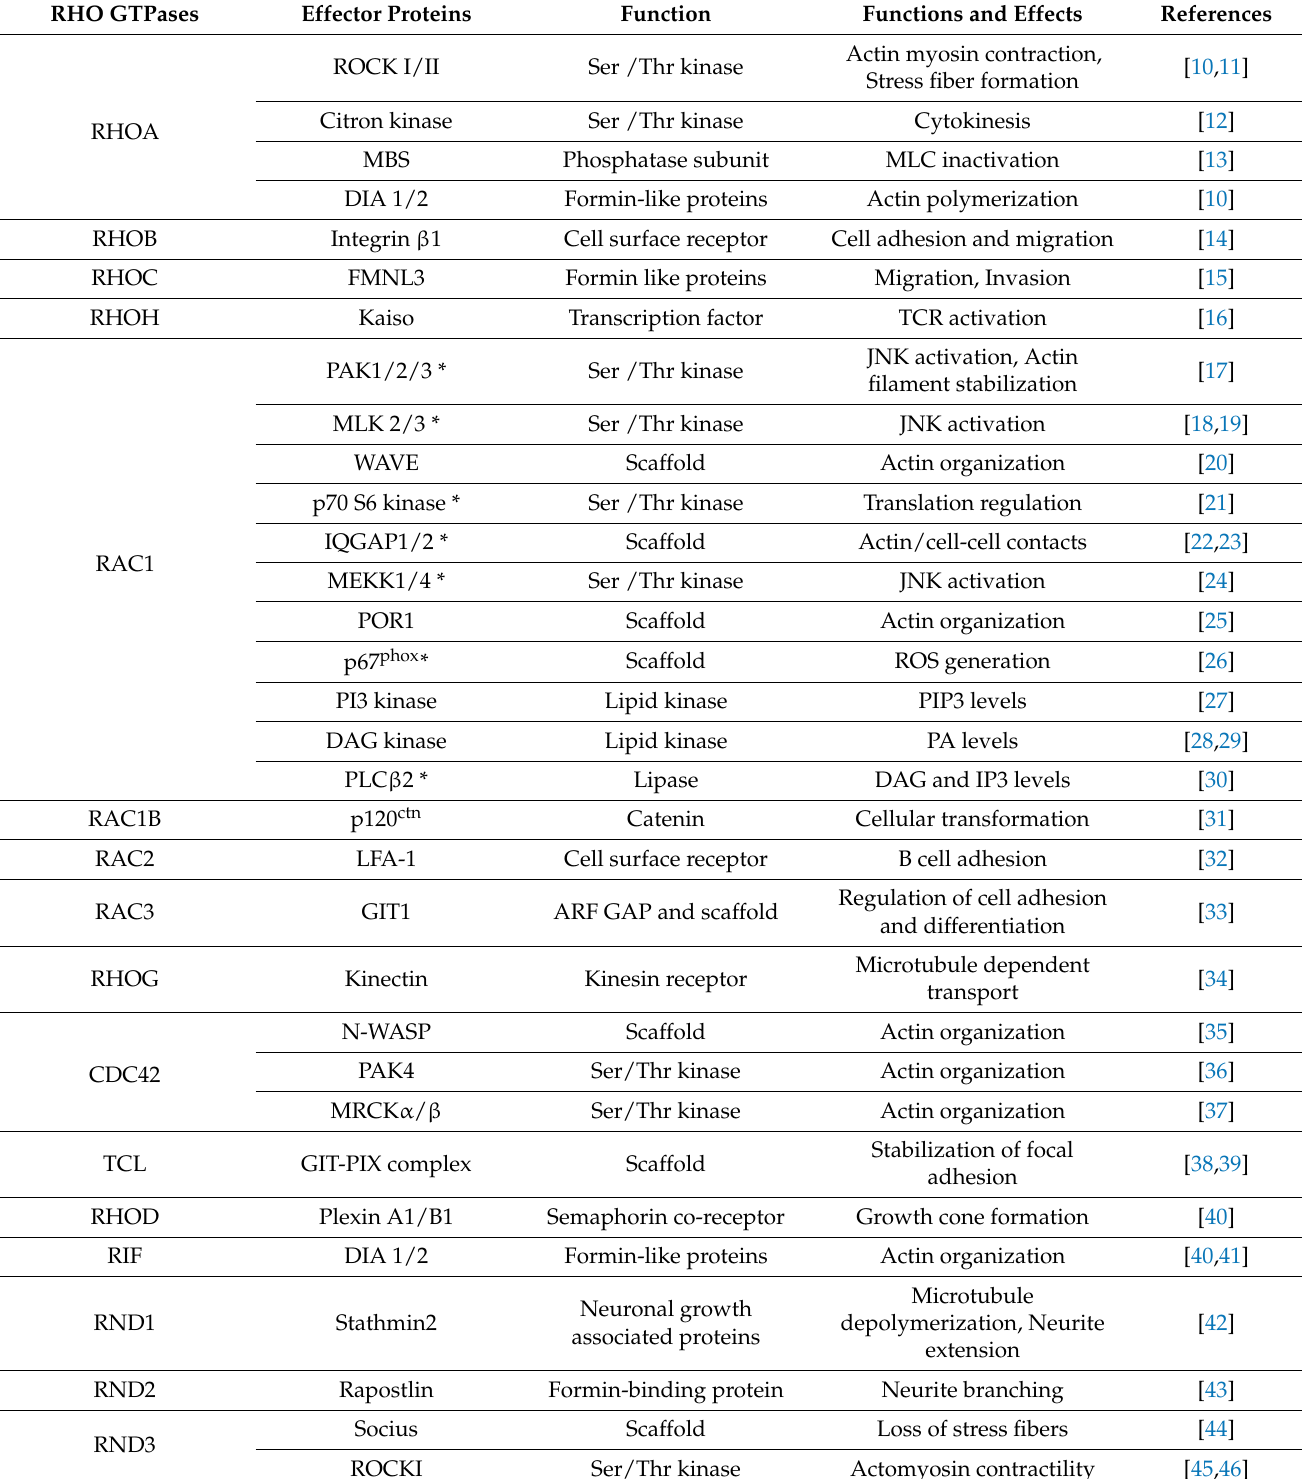
Table 1. RHO GTPases, potential effectors and their functions in mammalian